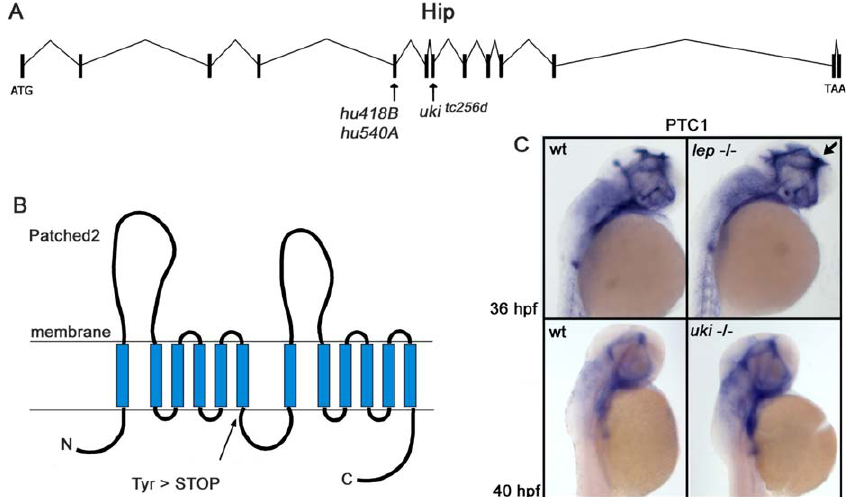
Figure 6. Premature Stop Codons Were Identified in the uki and lep Mutant in Hip and Ptc2, Respectively (A) Schematic representation of the genomic organization of the Hip gene. All three alleles of the uki mutation contain premature stop codons positioned in exon 5 and exon 7. (B) Representation of the protein structure of Ptc2 shows that the identified nonsense mutation is positioned after the sixth transmembrane domain, probably resulting in a malfunctioning protein. (C) ISH experiments show that Ptc1 expression is increased in uki and lep (arrow), confirming the aberrant activation of the Hh signaling pathway. DOI: